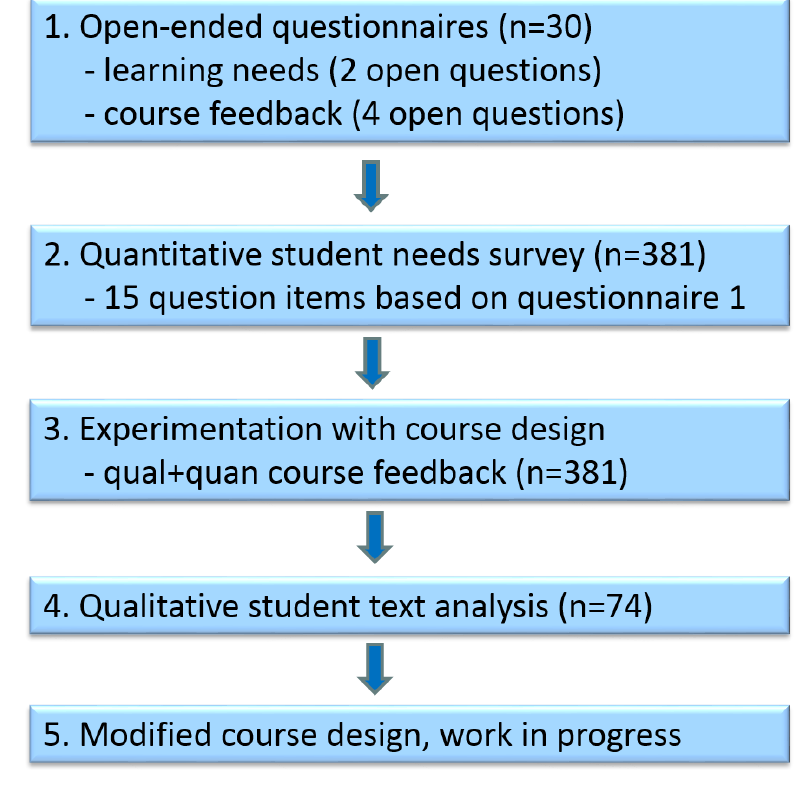
Fig. 1. Process of data